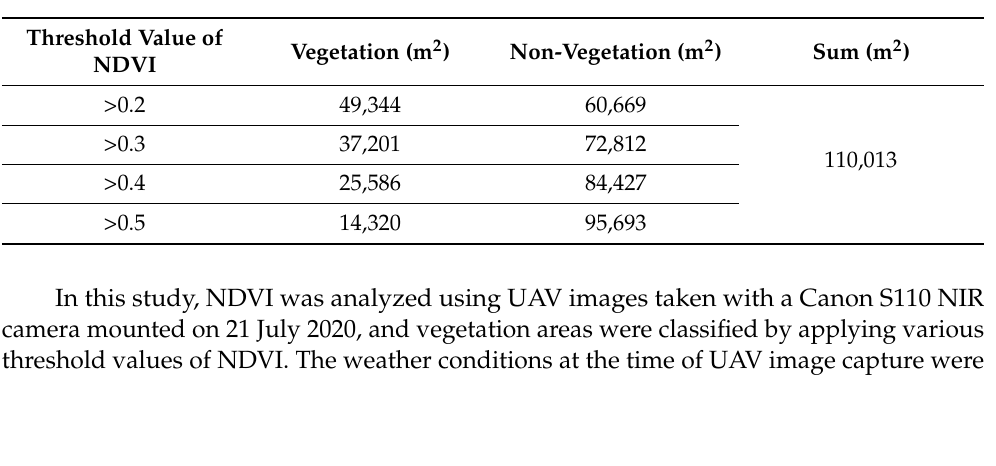
Figure 11. Vegetation map according to the threshold value of NDVI. Table 6. Vegetation area according to the threshold value of NDVI.